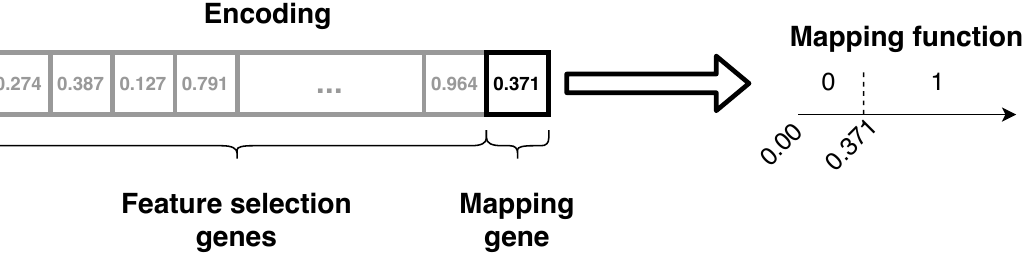
Figure 3. The self-adaptation with mapping gene in the encoding for feature selection task. The mapping value presented in this example are determined by the genotype and are not fixed, but adapt during the evolution process.